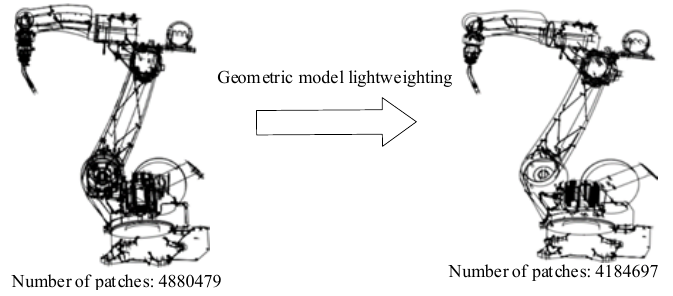
Figure 2. Number of patches before and after model lightweighting.